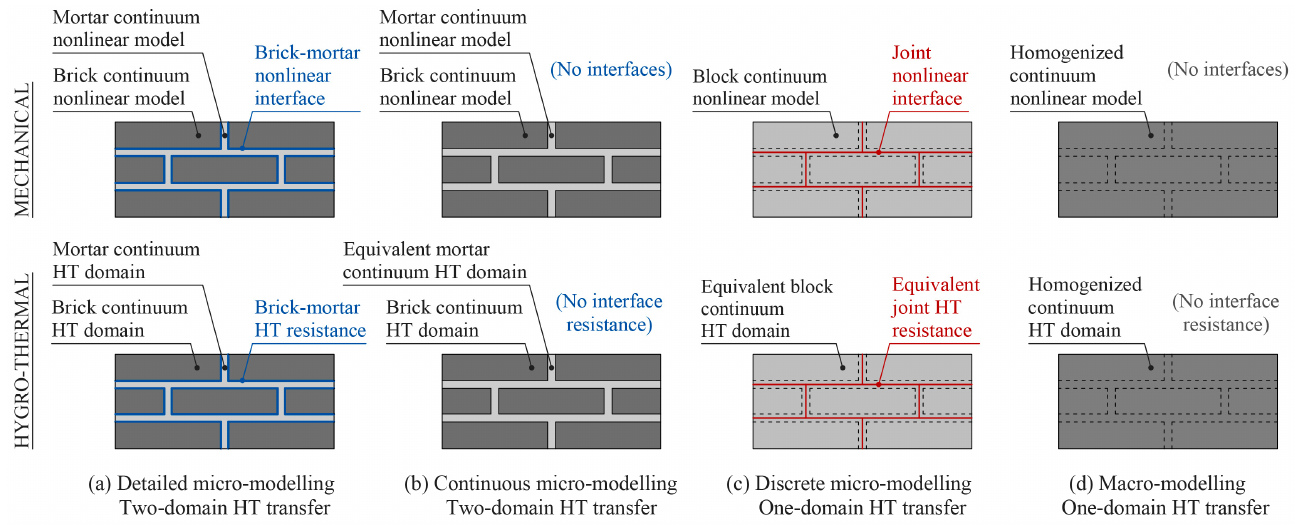
Figure 1. Modeling strategies for masonry. Adapted from [35], following [34,36].